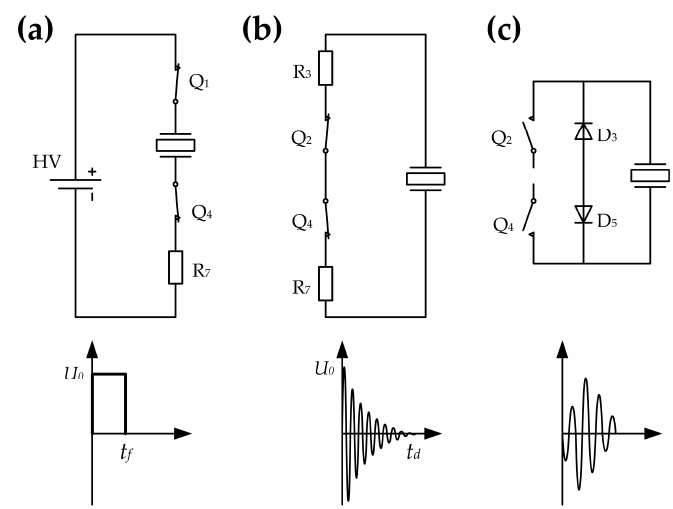
Figure 9. Simplified diagrams of the transducer excitation circuit at different stages: ( a ) acoustic emission stage; ( b ) discharge stage; and ( c ) echo signal detection stage.